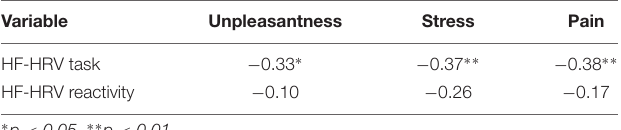
TABLE 2 | Pearson’s r correlations between HF-HRV task and reactivity variables, and VAS scales. Variable